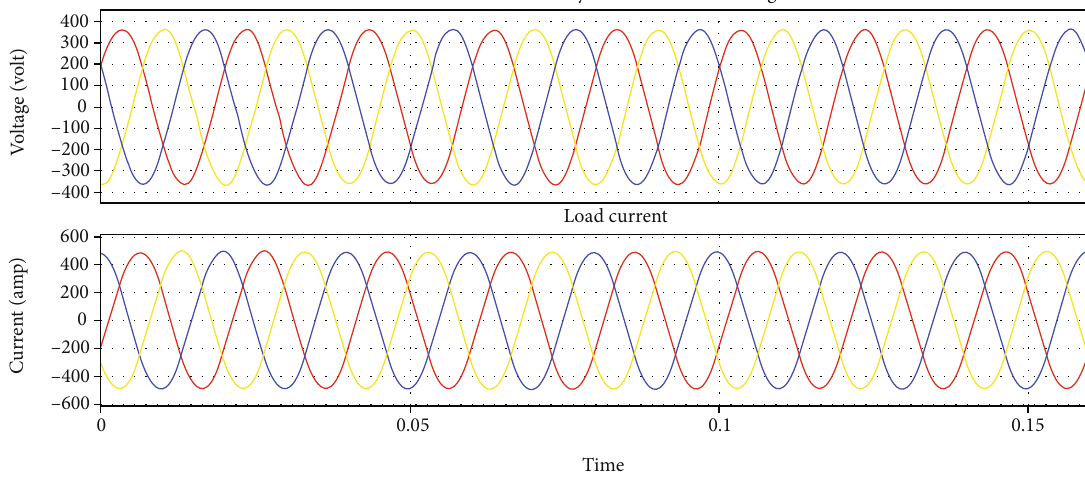
Figure 32: Waveform of the microgrid voltage and current.